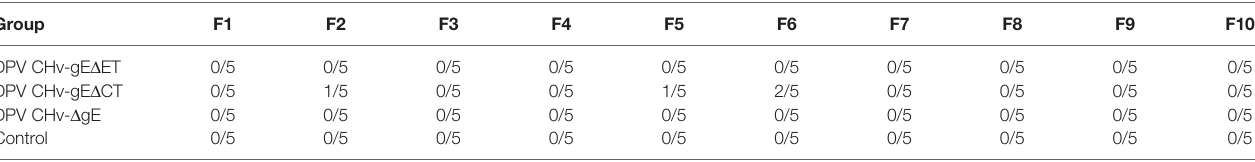
TABLE 2 | The number of death ducklings for each group.